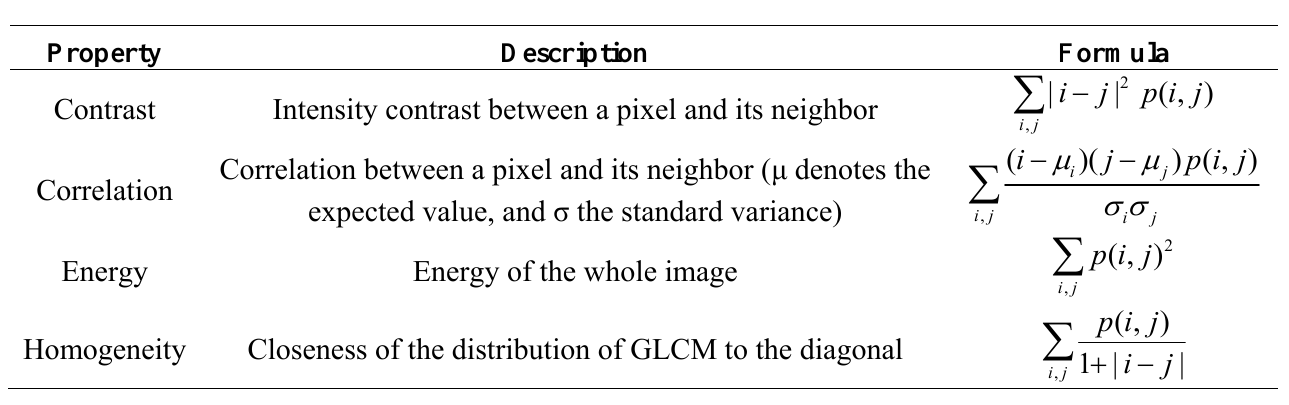
Table 2. Properties of